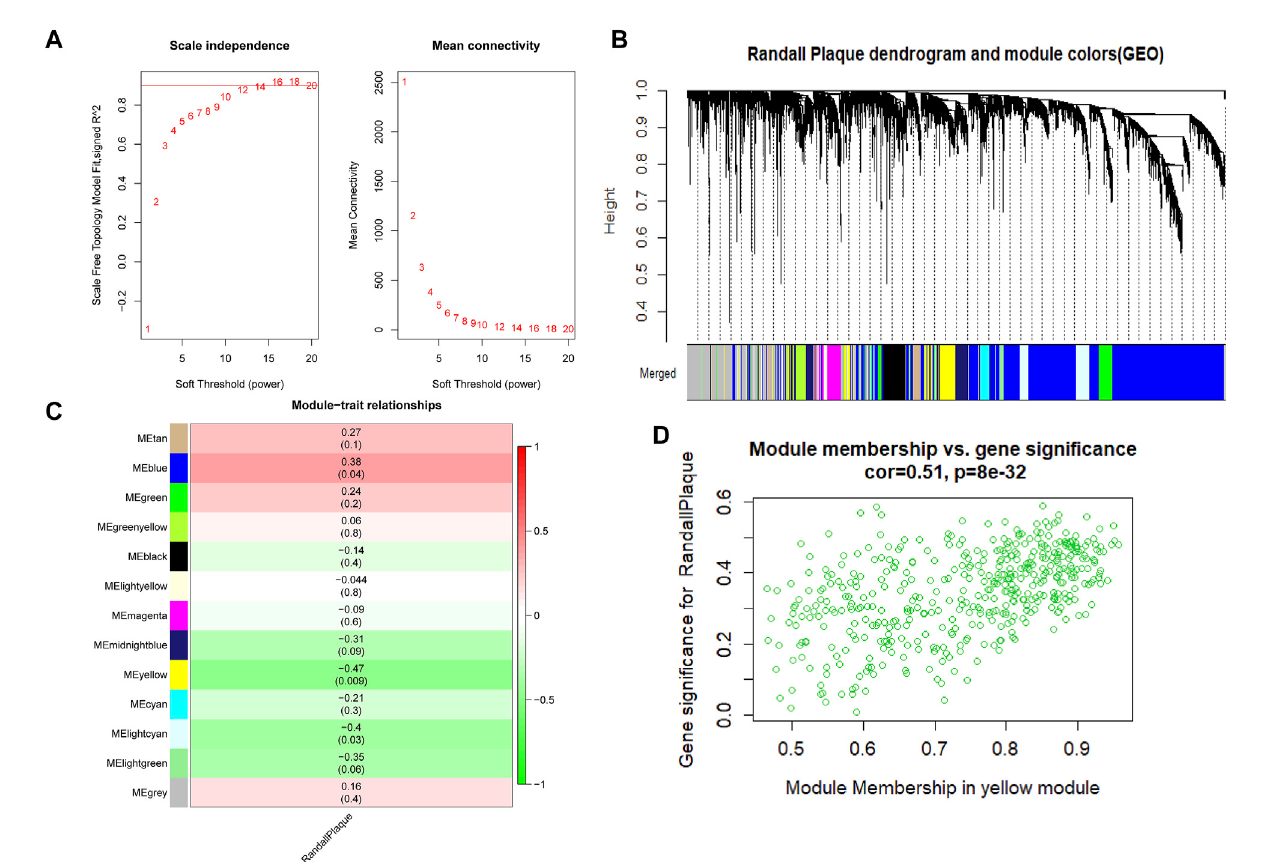
FIGURE 3 (A) Red line represents the reasonable soft power value in WGCNA analysis. (B) Randall ’ s plaque genes merged into various color modules in the dendrogram, and most genes are clustered inthe blue module. (C) Various colored modules show the correlation valuesand p -values in brackets. (D) Scatter plot shows the degree to which genes belong to the yellow module on the x -axis and the coef fi cient of gene correlated with Randall ’ s plaque on the y